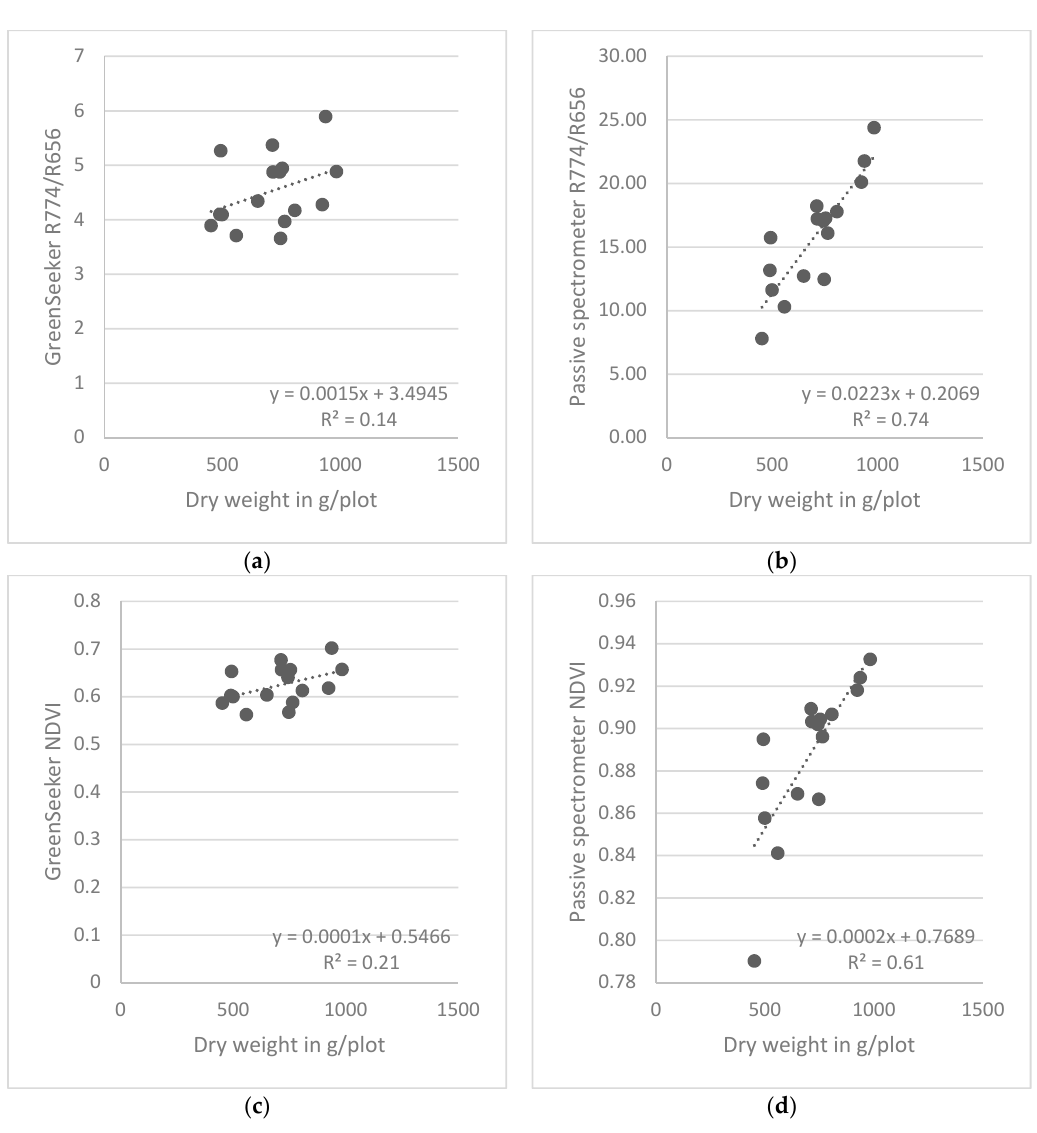
Figure 6. Relationships between spectral indices derived from the two types of sensors and plant dry weight at ZS 65 for barley, obtained from linear regressions combining the four different row designs.